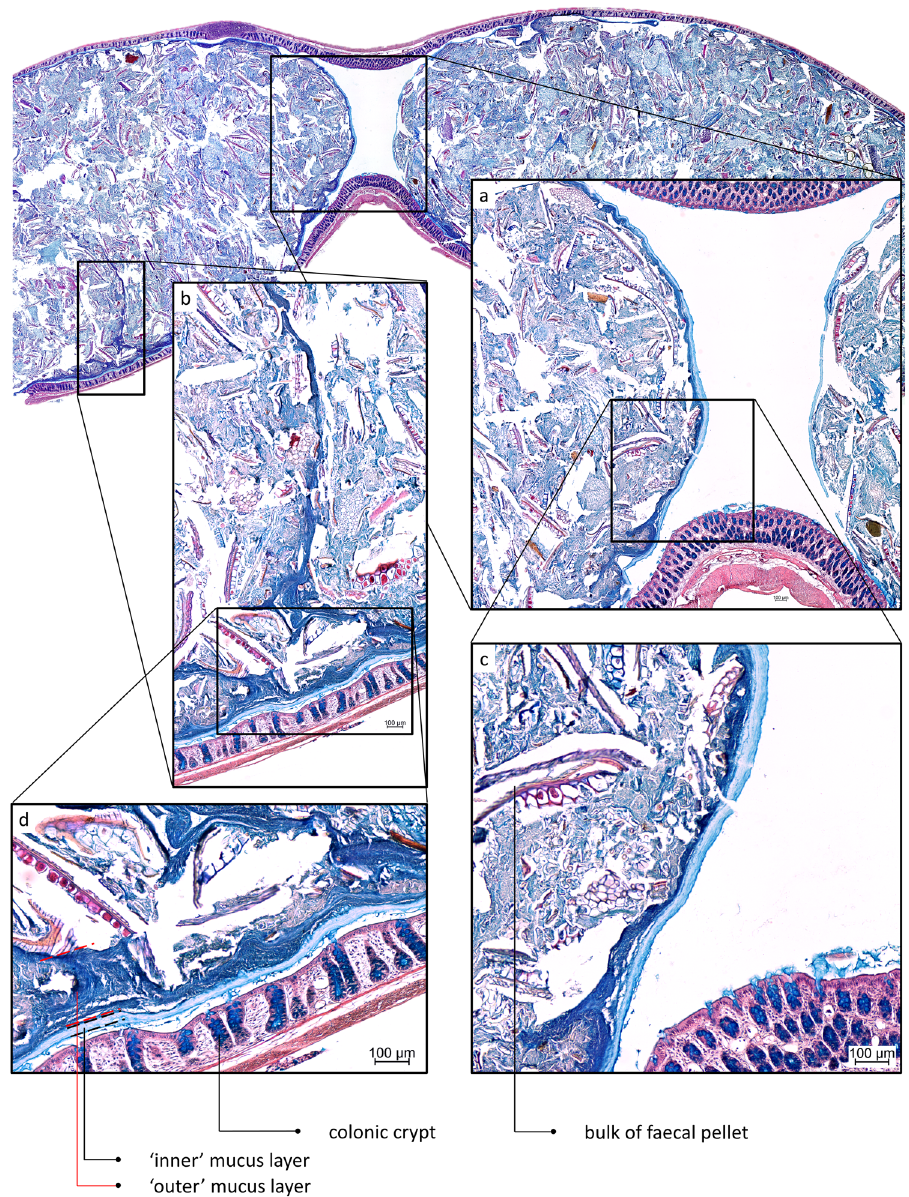
Figure 2. AB/H/E stained longitudinal section of distal rat colon containing faecal pellets. A sterile mucus layer covers the pellet completely. ( a ) The mucus layers attached to the faeces cover the entire pellet. ( b ) A line of bacteria-overgrown mucus penetrates the faecal pellet. ( c ) Sterile (light blue) and bacteria-overgrown mucus layers (dark blue) can be recognised, mucus production by goblet cells in the lumen is visible. ( d ) Sterile (‘inner’) and bacteria-overgrown (‘outer’) mucus layers, are recognised in a manner commonly observed in transversal